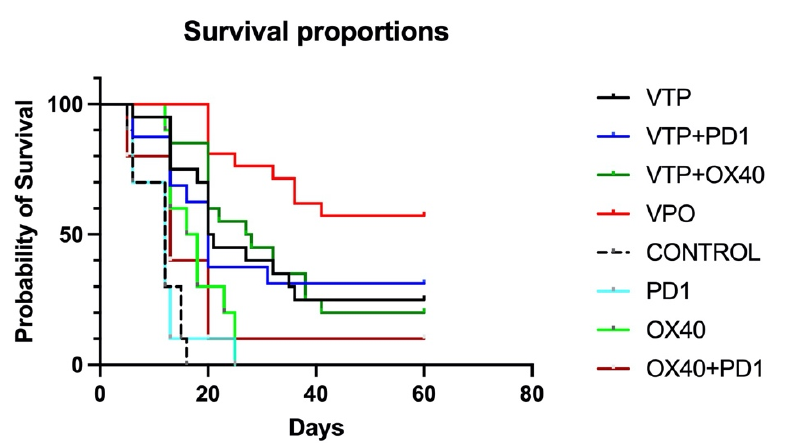
Figure 1. Combined treatment with OX40 agonist and PD1 inhibitor antibodies following VTP therapy suppresses primary tumor growth and improves survival. Percent survival of mice plotted by Kaplan-Meier methods ( p < 0.0001).